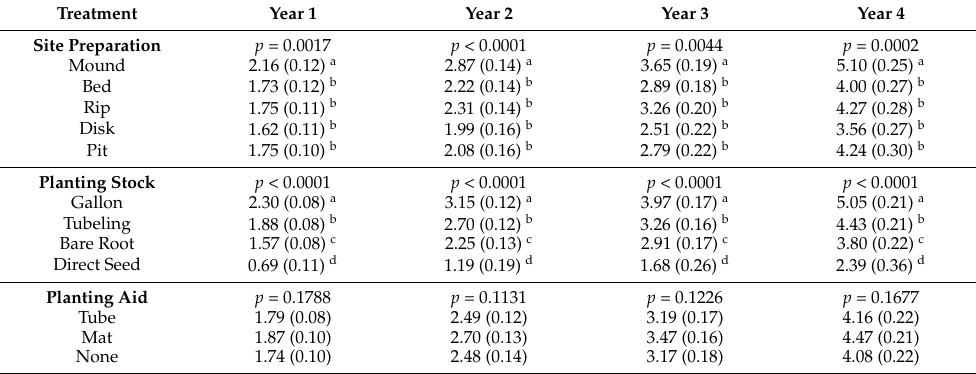
Table 2. Average height (m) (SE) for American sycamore in the Virginia Piedmont by site preparation, planting stock type, and planting aid. Values with different letters indicate statistically significant differences according to Tukey’s post hoc HSD ( p < 0.05). Bolded text indicates treatment category.